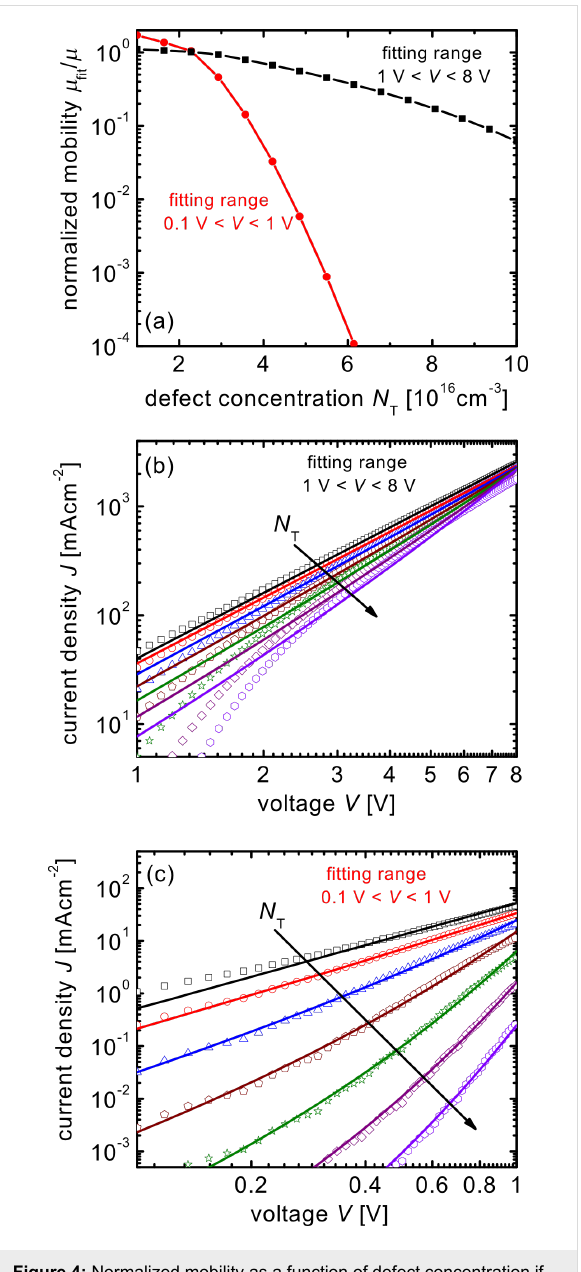
Figure 4: Normalized mobility as a function of defect concentration if the built-in voltage in Equation 8 is set to 0. Now, no correction for the barrier created by the charged defects is done and the mobility is underestimated at high trap concentrations. Because the current–voltage curve is affected by the traps mostly at low voltages, the mobility resulting from the fit will depend strongly on the range used for fitting. Reasonable fit quality is either reached if the fit is done for higher voltages V > 1 V or for lower V < 1 V. (b) and (c) show the fits (lines) to the drift–diffusion simulations (symbols) for the two different fitting ranges. Every second datapoint in (a) is presented in (b) and